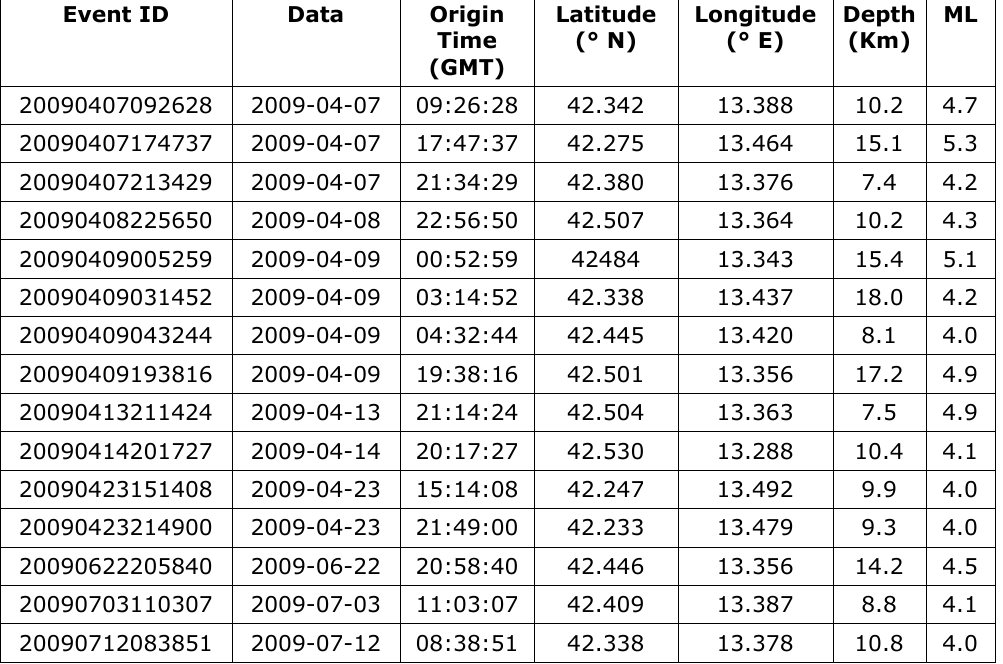
Table 1. Earthquake list for the present study (ML ≥ 4.0). The focal parameters come from the ISIDE bulletin (http://iside.rm.ingv.it/iside/standard/index.jsp; last accessed on December 4,